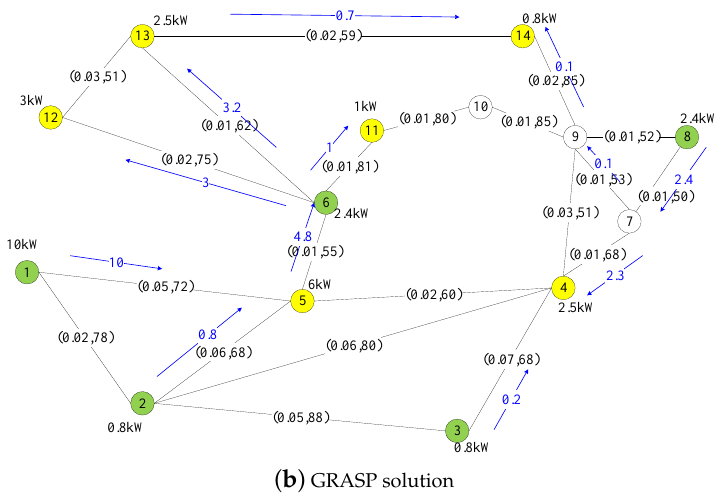
Figure 19. Routing of power at 6 pm on IEEE14 testbus by (a) the optimal method and (b) GRASP on the practical